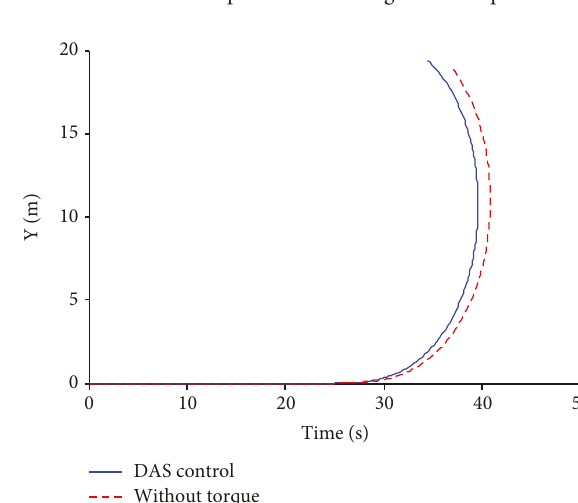
Figure 7: Comparison of steering wheel torque.